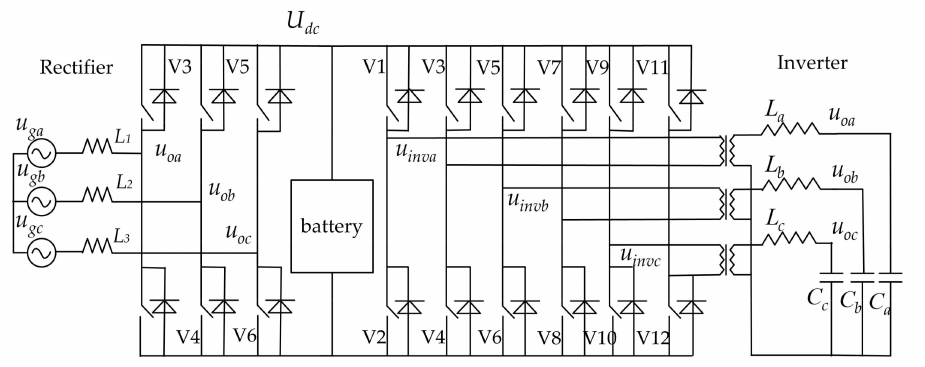
Figure 3. Structure of the three-port converter.